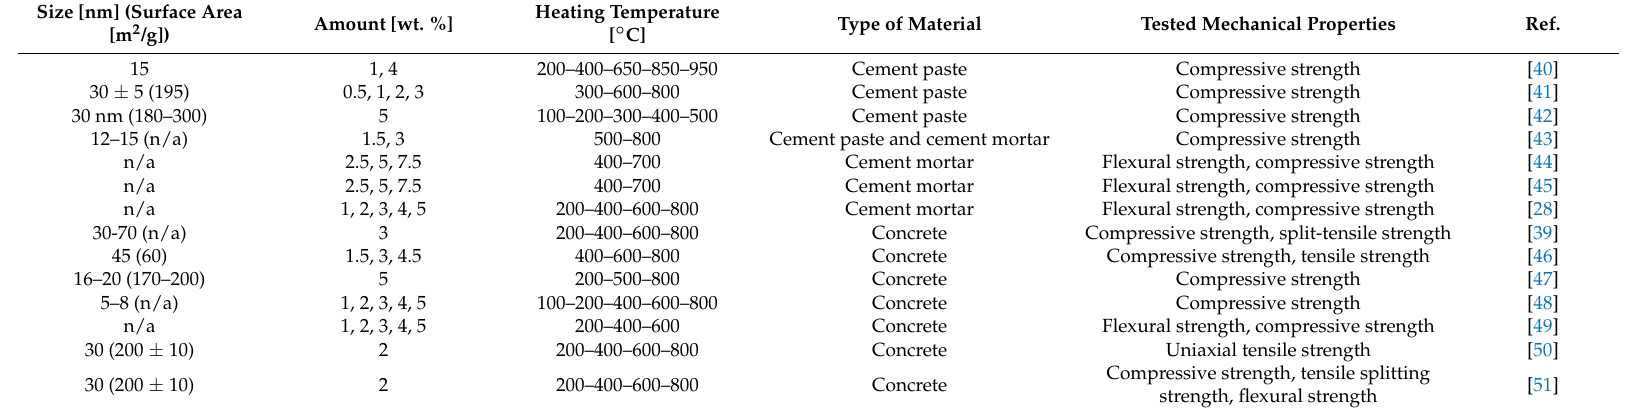
Table 2. Summary of available studies related to the effects of nanosilica (NS) on the thermal resistance of cement-based composites. Size [nm] (Surface Area [m 2